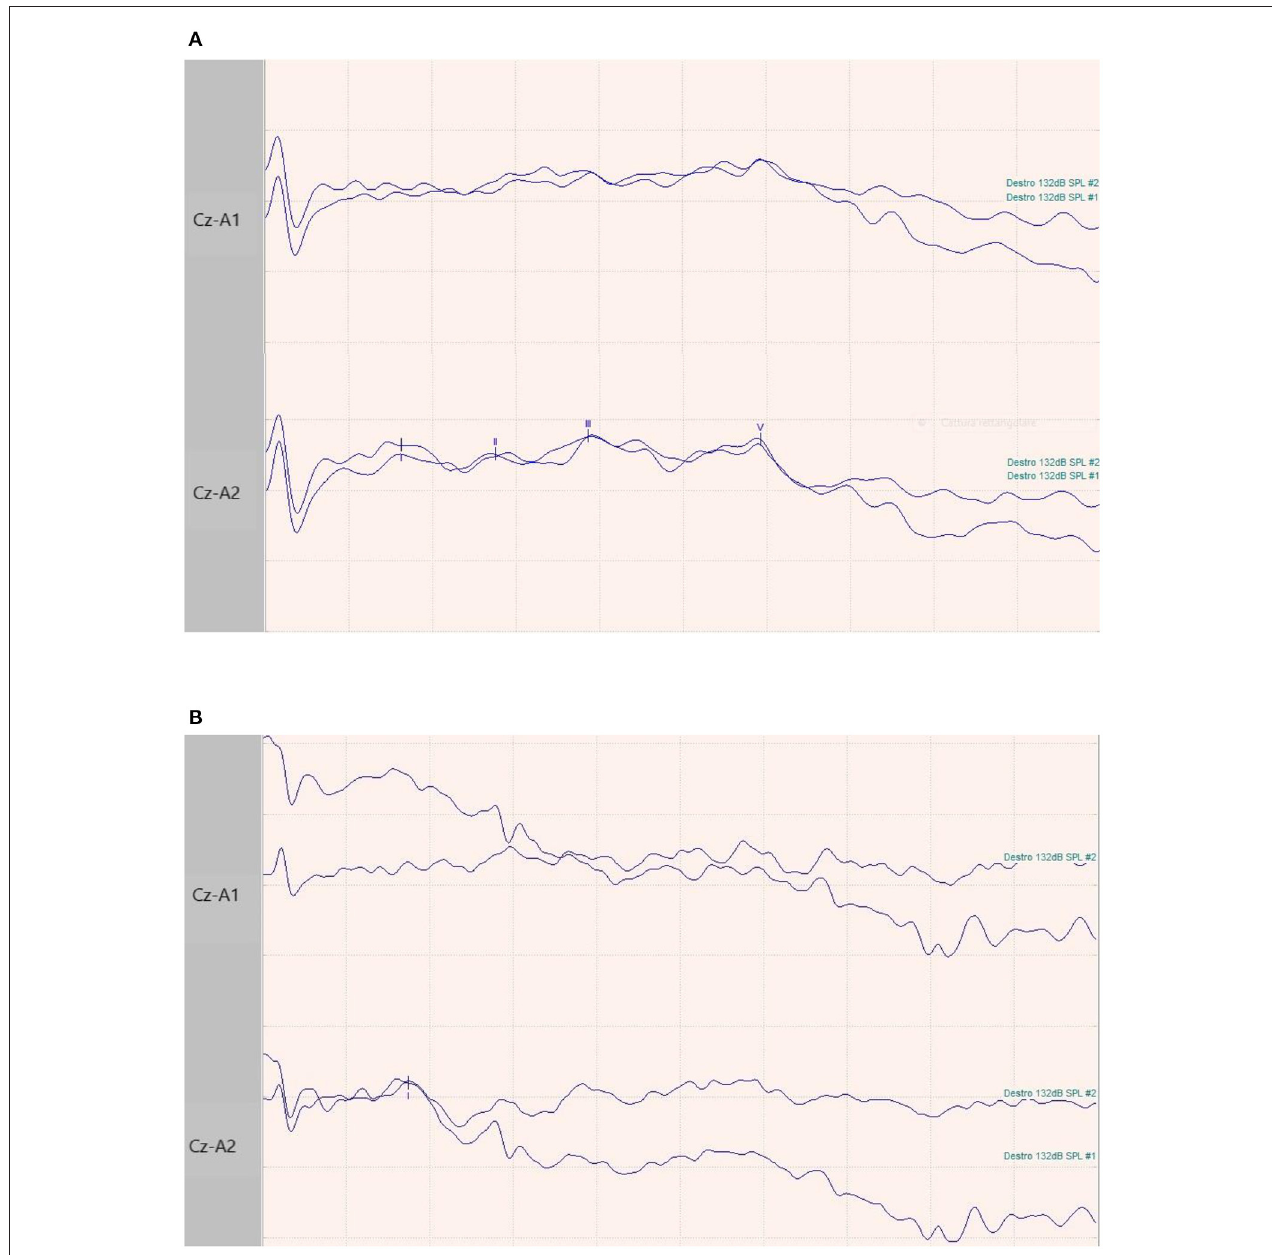
FIGURE 1 | BAEPs recordings in two patients. (A) 65-year-old male patient with normal I-III-V complex latency and amplitude and related inter-peak times. (B) 73-year-old female patient with normal latency and amplitude of I complex, and absence of III and V